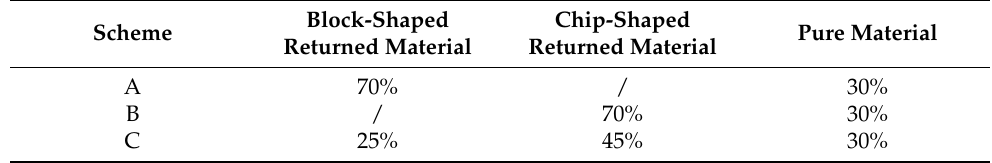
Table 1. Experimental scheme with different mass ratio of return materials. Scheme